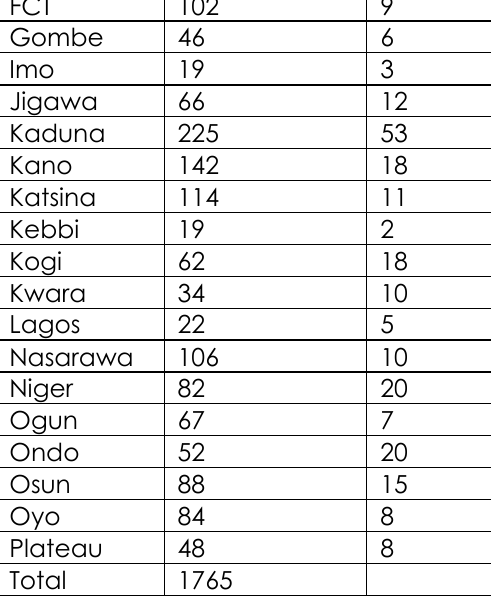
Table 5: Number of Children involved in Road Traffic Crashes on State Basis in 2017 State Number of Children Children Killed Injured on Road Traffic Crashes Abia 11 0